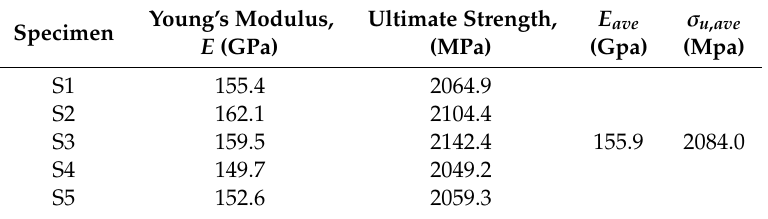
Figure 1. Schematic diagram and photograph of testing system. Table 1. Mechanical Properties of CFRP tendons measured from